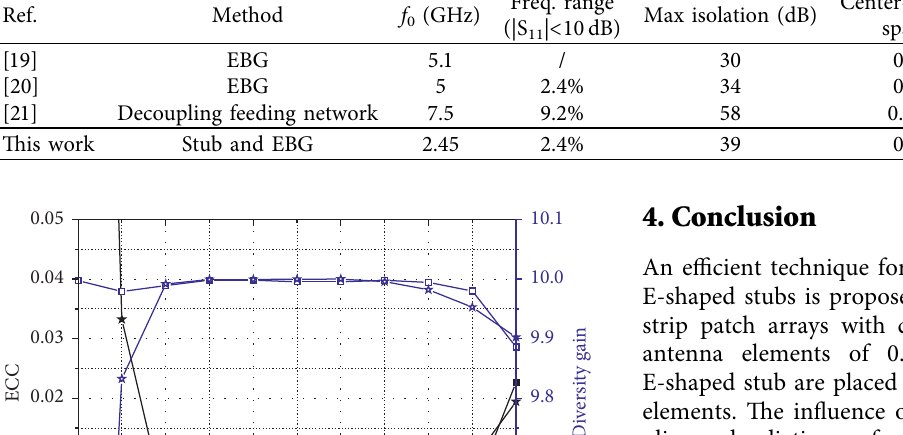
Table 2: Dimensions of optimized parameters of the proposed antenna. Ref.